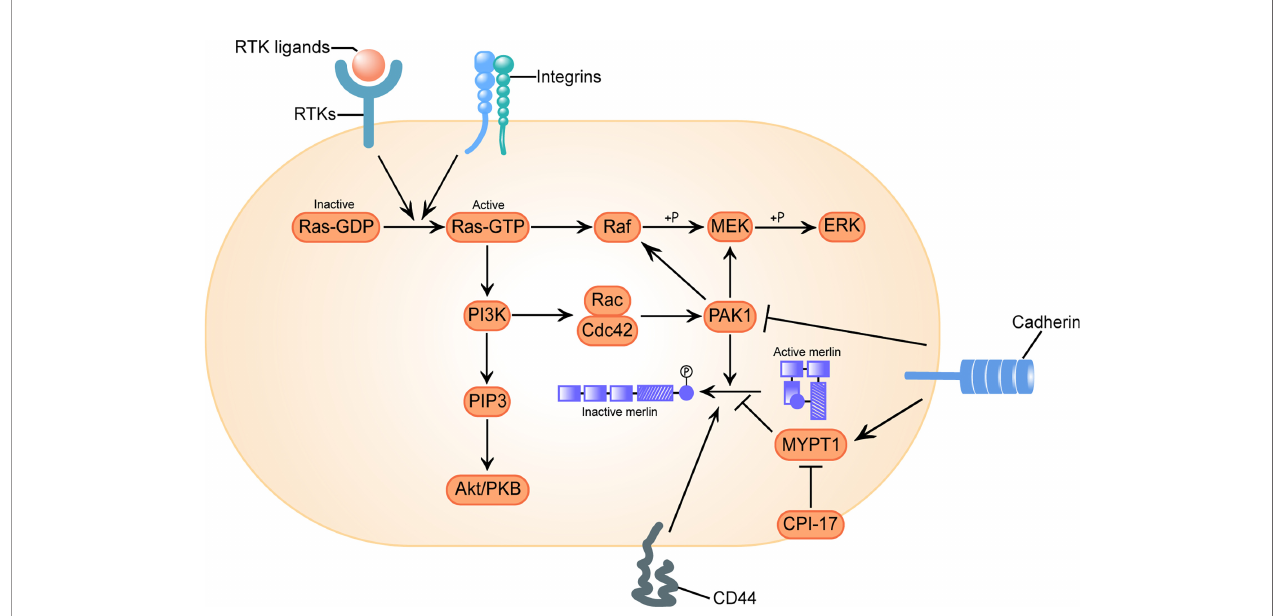
FIGURE 1 | Con fi gurational changes of Merlin in response to receptor tyrosine kinases (RTKs), integrins, clusters of differentiation 40 (CD40) and cadherins signal stimulation. Activation of RTKs and integrins triggers GTP loading of Ras, which drives three mitogenic downstream pathways: Raf/MEK/ERK, PI3K/Rac/PAK, and PI3K/PIP3/Akt/PKB. p21-activated kinase 1 (PAK1) is an effector of the downstream pathway activated by Ras, which phosphorylates merlin at Ser 518 and converts it to an inactive conformation. Conversely, myosin phosphatase targeting subunit 1(MYPT1) dephosphorylates and reactivates merlin. C-kinase potentiated protein phosphatase-1 inhibitor of 17 kDa (CPI-17) acts as a cellular inhibitor of MYPT1, causes loss of function of merlin. CD44 inactivates merlin. Engagement of cadherins inactivates PAK1 and activates MYPT1, inducing merlin ’ s tumor suppressor function in a two-fold way. Here we adopt the broadly accepted hypothesis that phosphorylated merlin is the inactive